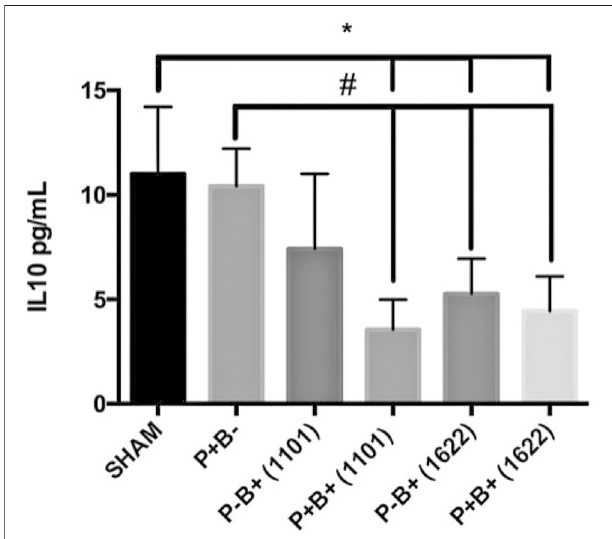
FIGURE 6 | Serum levels (pg/ml) of IL-10 in C57Bl/6 mice submitted to different treatments for 45 days: SHAM (negative control), P + B- (positive control), P-B+ (1101) ( B. breve 110 1A ), P + B+ (1101) (microbial consortium + B. breve 110 1A ), P-B+ (1622) ( B. bi fi dum 162 2A ) and P + B+ (1622) (Microbial consortium + B. bi fi dum 162 2A ). * Statistically signi fi cant difference in relation to negative control (SHAM), # Statistically signi fi cant difference in relation to positive control (P + B-). ANOVA, Tukey ’ s multiple comparison, p < 0.05%. Data representative of two independent experiments ( n (cid:1) 8 mice/ per